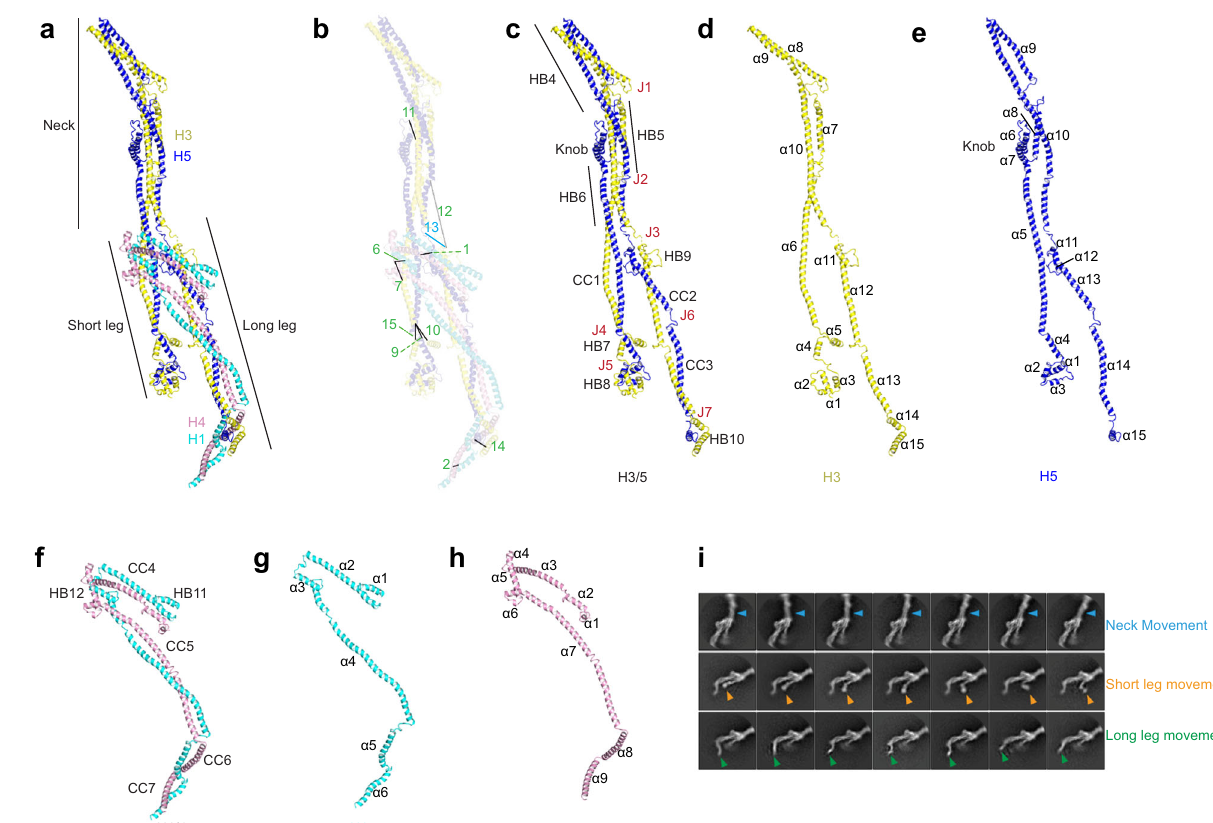
Fig.5|Structureofthetailofaugmin.a Overallarchitectureofthetailofaugmin with helices from H1/3/4/5 depicting the neck, short, and long legs. b Intersubunit crosslinksaslabeledinTable1aremappedonthestructure.Intersubunitcrosslinks below30Å(black),above30Å(lightgray),andonecontainingapeptidefromaH5 region not modeled within augmin ’ s structure (blue). c H3/5 dimer with labeled features: CC1 – 3, HB4 – 8, J1 – 7, and the knob. d H3 with labeled α -helices